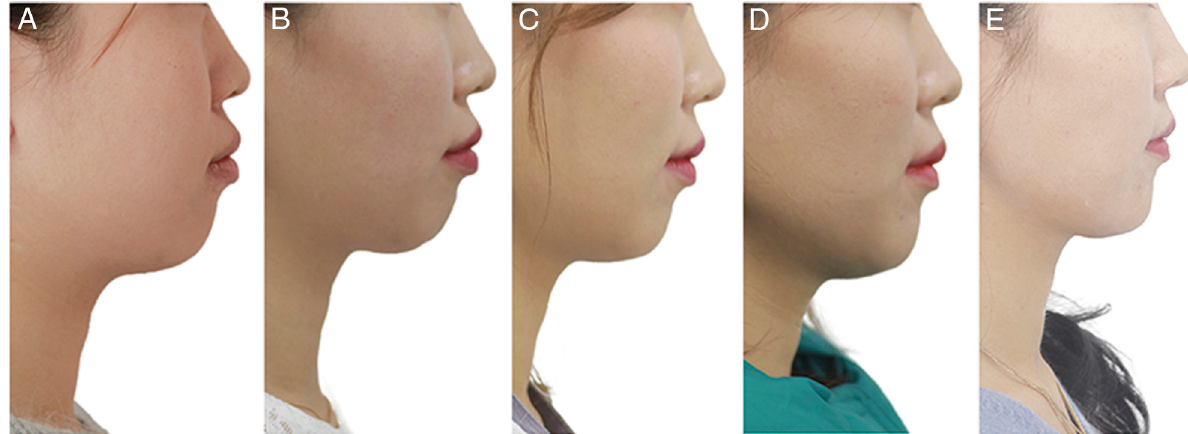
Figure 10. ( A) pretreatment facial profile photograph; (B–D) treatment facial profile photographs; (E) posttreatment facial profile photograph: the profile of the patient changed from convex to straight and a better-defined cervical-mental angle was